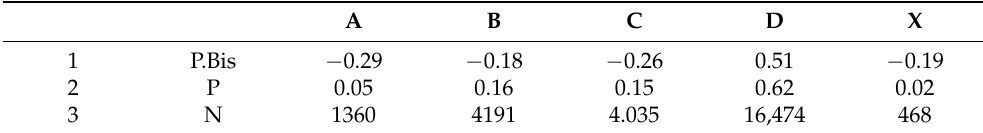
Table 2. Item analysis of the second task.